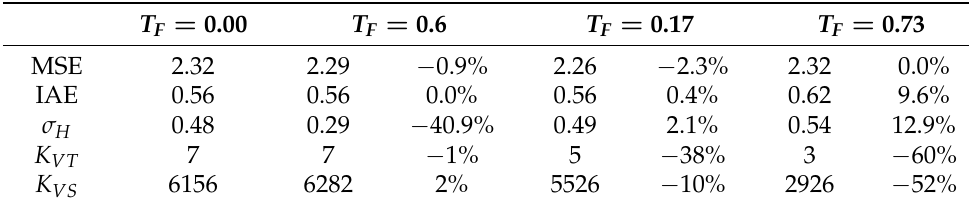
Table 7. Filtering impact on G 3 ( s ) loop.